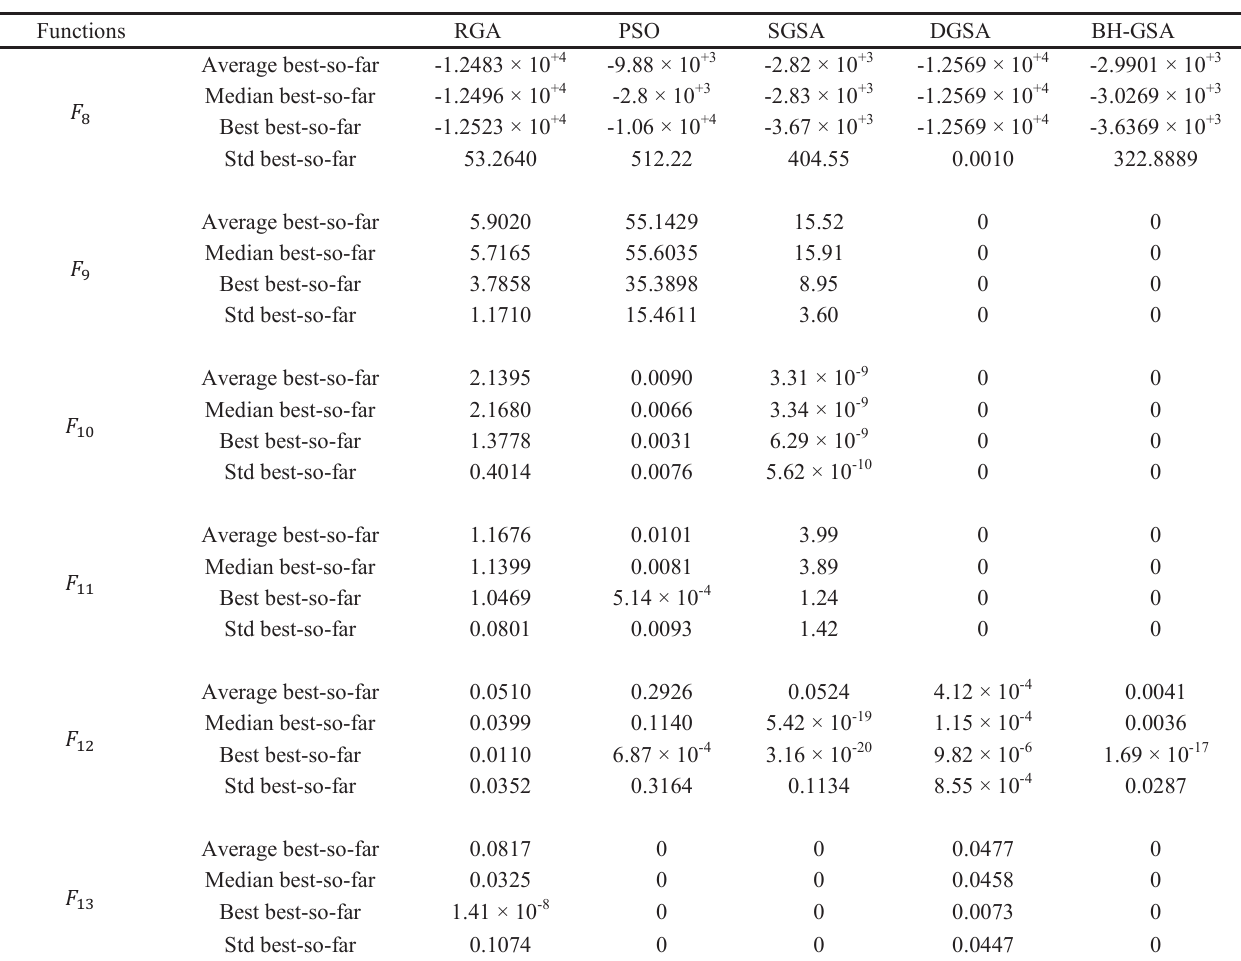
Table 5. Minimization result of benchmark functions in Table 2 with